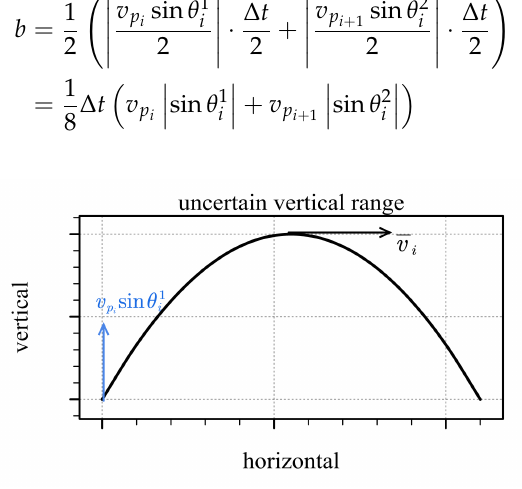
Figure 6. Uncertain vertical range estimation based on turning